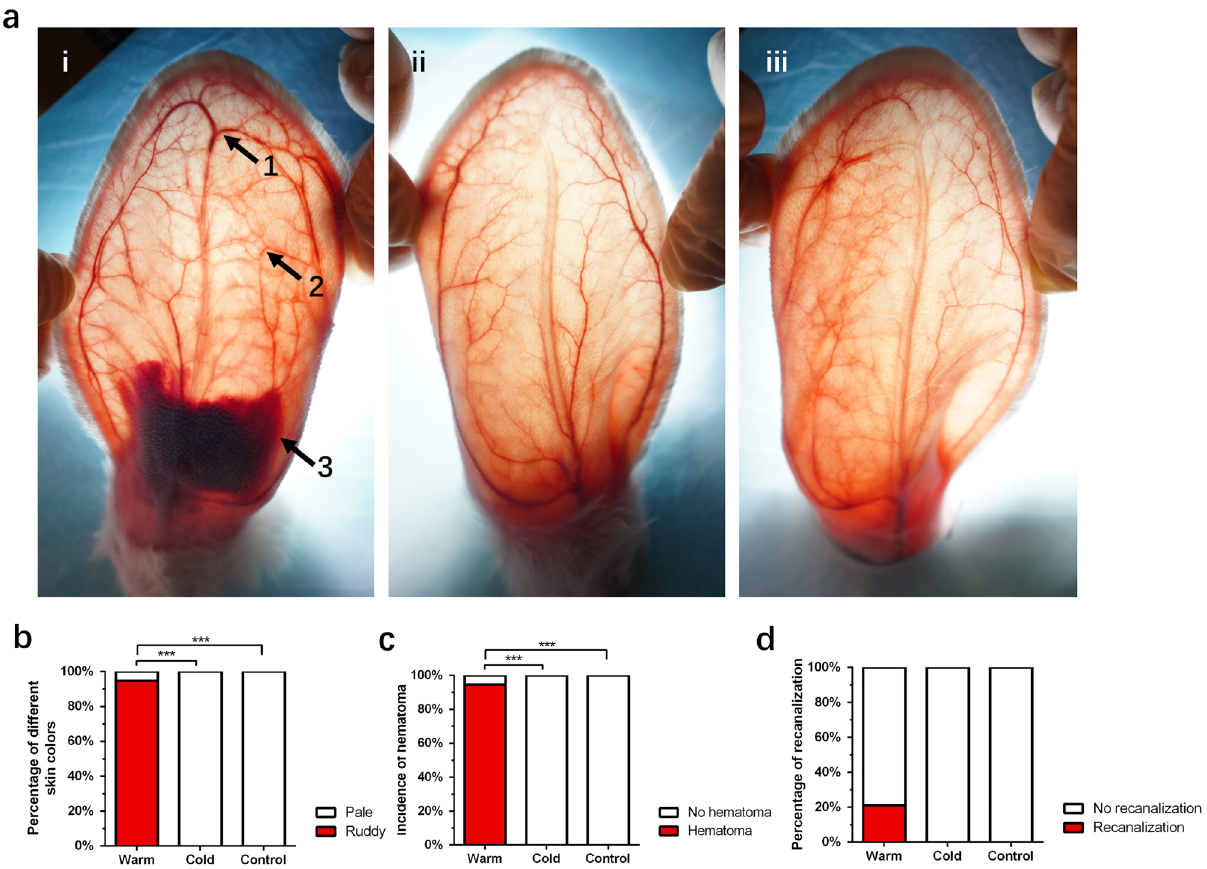
Figure 4. Changes in three groups at 30 min after intravascular injection. ( a ) i: warm compress. Arrow 1: vascular recanalization and filling; Arrow 2: expansion of the peripheral branch blood vessels; Arrow 3: hematoma. ii: cold compress. iii: control group. ( b ) The skin color changes in different groups at 30 min after intravascular injection. ( c ) Incidence of hematoma in different groups at 30 min after intravascular injection. ( d ) Percentage of vascular recanalization in different groups at 30 min after intravascular injection. ***P < 0.000. Figure was created in Adobe Illustrator software (version 22.1; https:// www. adobe. com/ produ cts/ illus trator. html) and GraphPad Prism software (version 9.4.1; https:// www. graph pad. com/ scien tific- softw are/